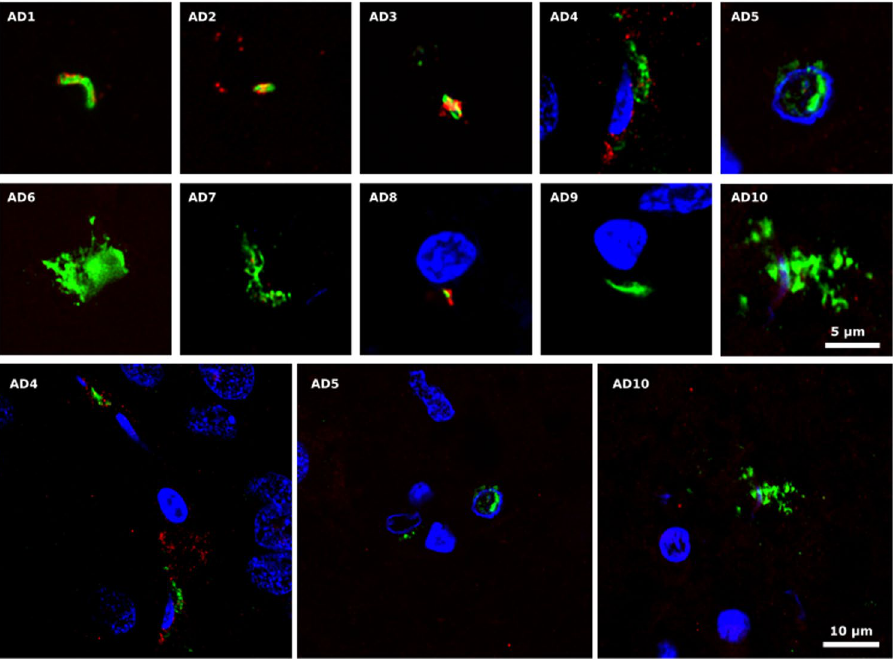
Figure 5. Peptidoglycan in ERH sections from AD patients. ERH samples were processed as described in Materials and Methods. Samples were first immunostained with mouse monoclonal antibody (1:20 dilution) against peptidoglycan (green) and afterwards with rabbit polyclonal antibody (1:50 dilution) against C. albicans (red). DAPI staining of nuclei appears in blue. Scale bar as shown in the